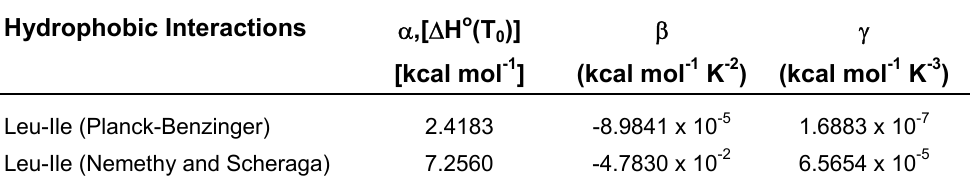
)] β γ 0 [kcal mol -1 ] (kcal mol -1 K -2 ) (kcal mol -1 K -3 )